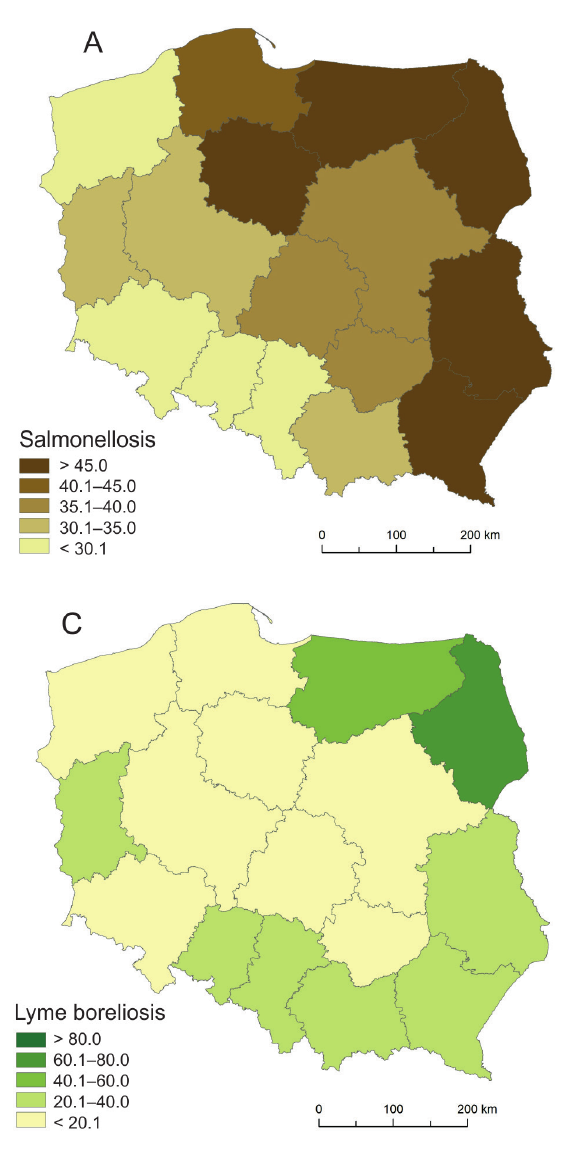
Fig. 2. Mean yearly number (per 100 000 inhabitants) of selected CRD: A – salmonellosis intoxication (1999– 2014), B – influenza infections (1973–2014), C – Lyme boreliosis (2003–2014), D – tick born viral encephalitis (TBvE,